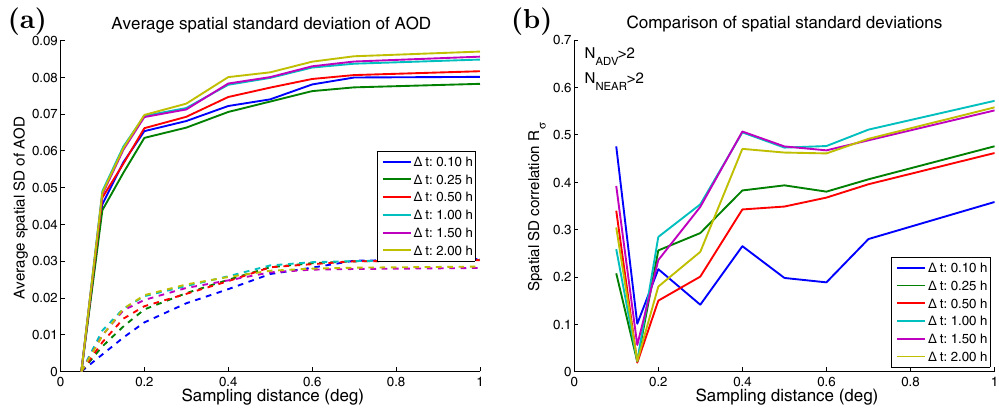
Figure 6. (a) Average spatial standard deviation of AOD for AATSR (solid lines) and for AERONET (dashed lines) for the collocated cases as function of the sampling distance for several temporal sampling window sizes. (b) The correlation coefficient R σ for collocated spatial AOD variability data as function of the sampling